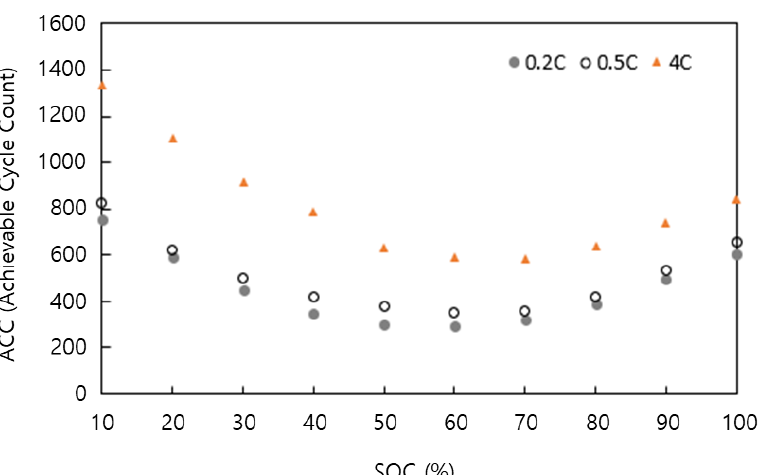
Figure 8. Wear cost for the BESS that costs $4.6 M per unity. A 4C system (4-MW/1-MWh) obtained using the DOD-ACC curve in Figure 4.